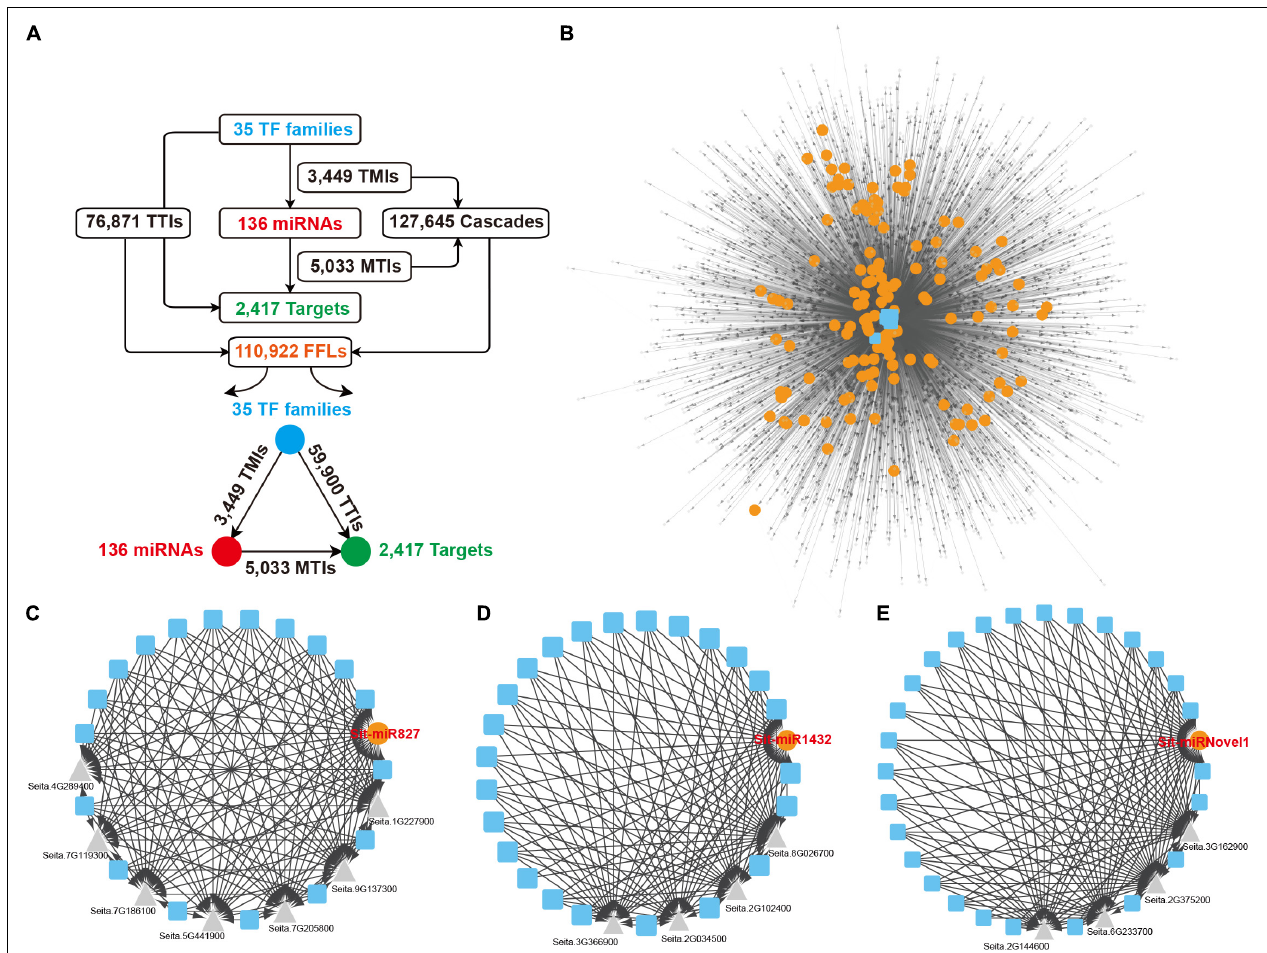
FIGURE 6 | FFLs regulatory network centered by miRNAs. (A) Detailed information of all interactions and miRNA-centered FFLs regulatory network from the overall dataset. (B) miRNA-centered FFLs regulatory network. Blue squares, orange dots, and gray triangles represent TFs, miRNAs, and targets, respectively. (C–E) Three examples of local FFL networks centered by Sit-miR827, Sit-miR1432, and Sit-miRNovel1. Blue squares, orange dots, and gray triangles represent TFs, miRNAs, and target genes, respectively. FFLs, feed forward loops; TFs, transcriptional